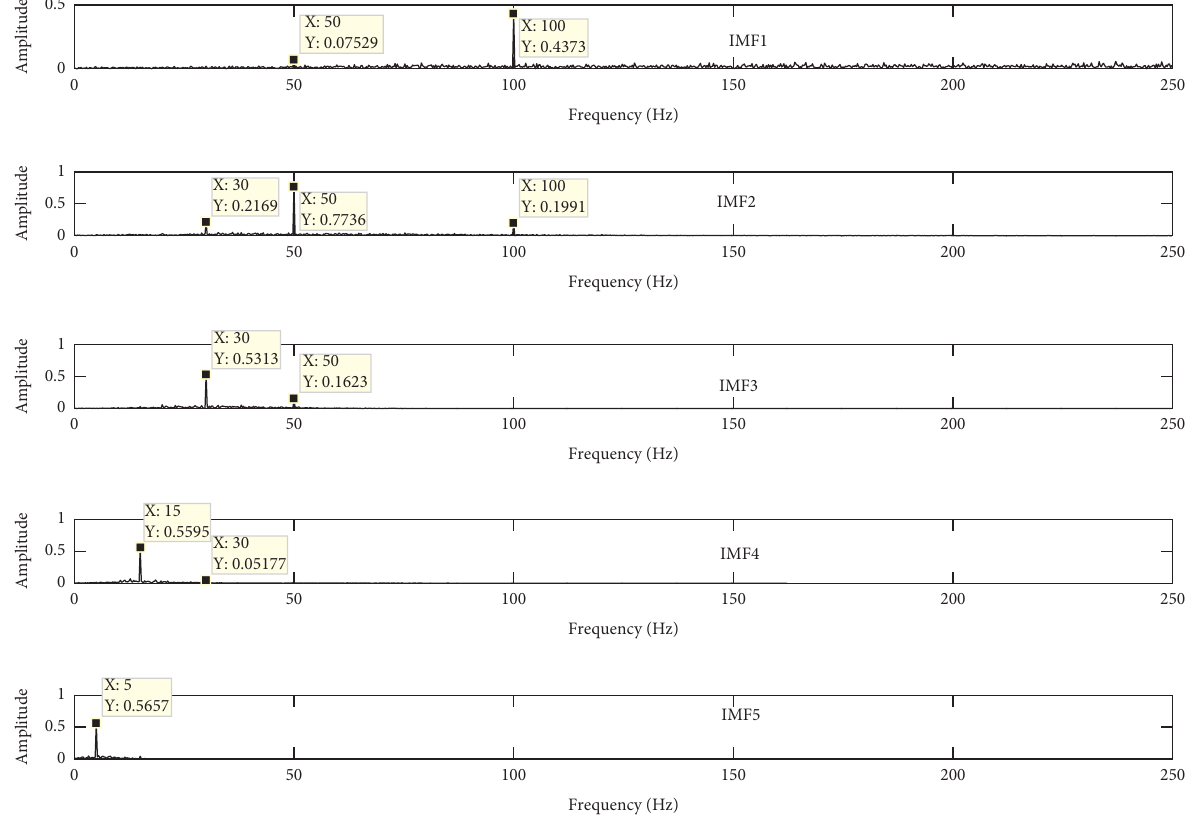
Figure 7: Frequency spectrum of IMF 1 , IMF 2 , IMF 3 , IMF 4 , and IMF 5 . Table 1: Main datum of EEAF method and designated signal.